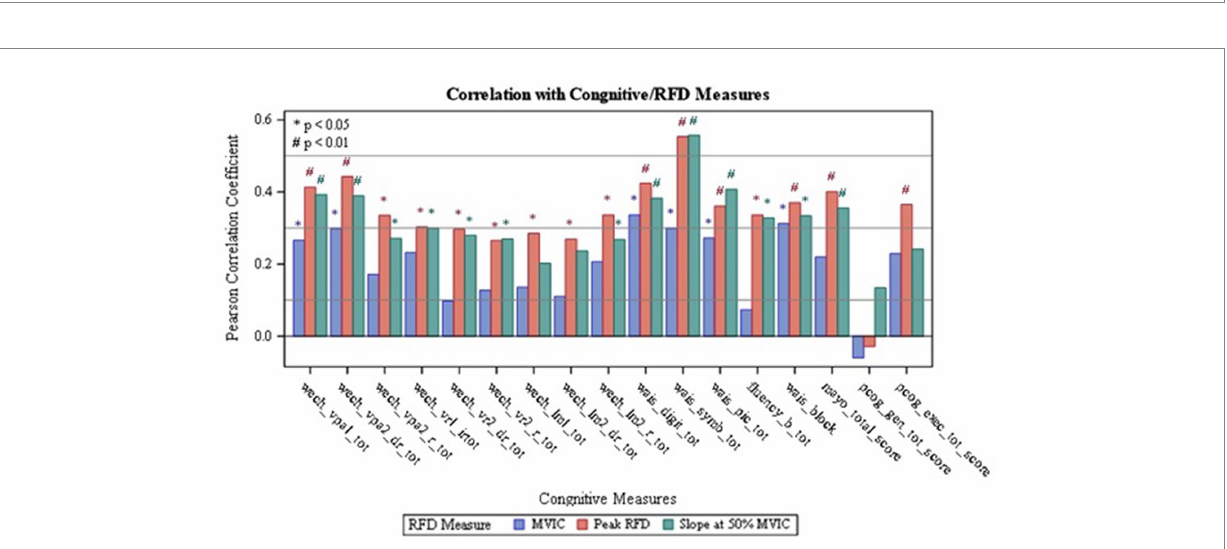
FIGURE 2 Correlation of Non-dominant RFD with Cognitive Measures; wech_vpal_tot — Total Visual Paired Associates I — Immediate Recall Raw Score; wech_ vpa2_dr_tot — Total Verbal Paired Associates II — Delayed Recall Raw Score; wech_vpa2_r_tot — Total Verbal Paired Associates II- Recognition